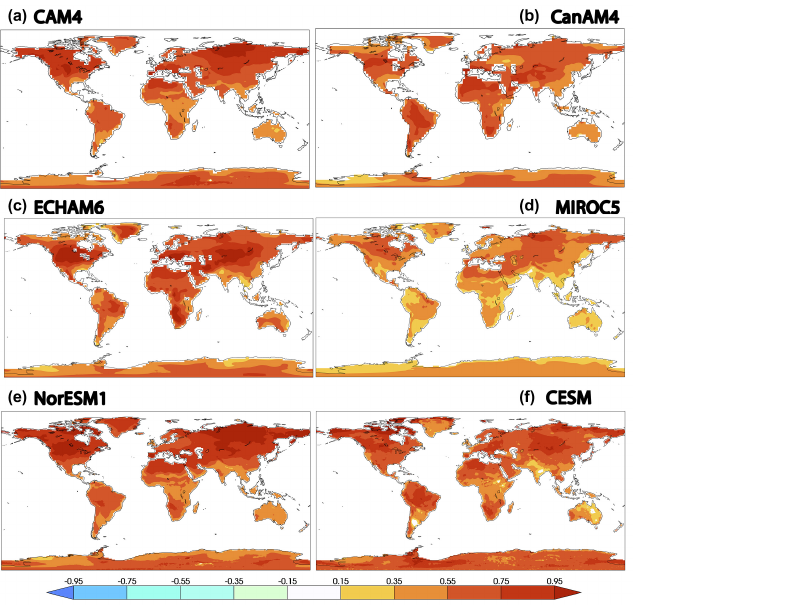
Figure A2. Differences in average hot season surface air temperature ( ◦ C) between the 2.0 ◦ C and 1.5 ◦ C HAPPI simulations. (a) CAM4. (b) CanAM4. (c) ECHAM6. (d) MIROC5. (e) NorESM1. (f)